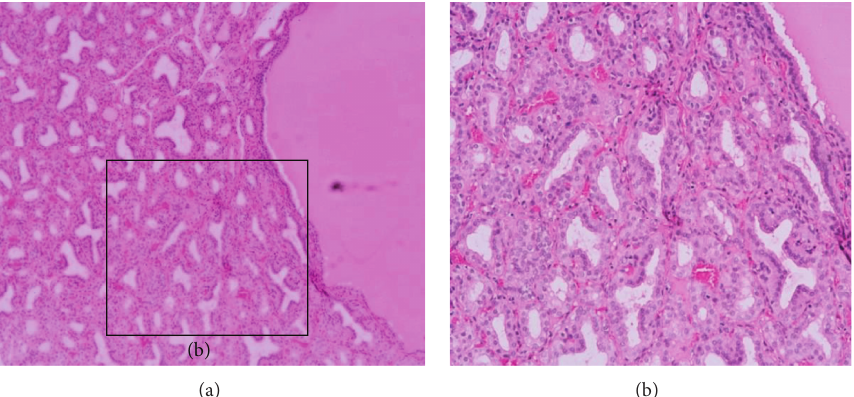
Figure 6: Thyroid sections. (a) A macrofollicular structure contrast with collapsed and folded empty follicular structures. H&E, 80x. (b) Detail of collapsed and folded empty follicular structures in ewes, H&E, 160x.